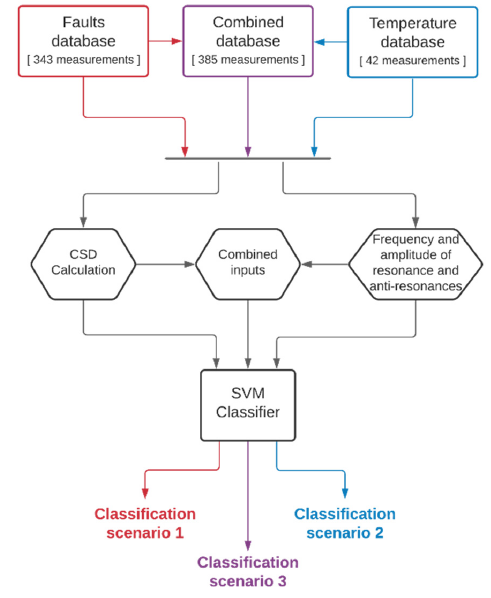
Figure 4. Flowchart for classification methodology.